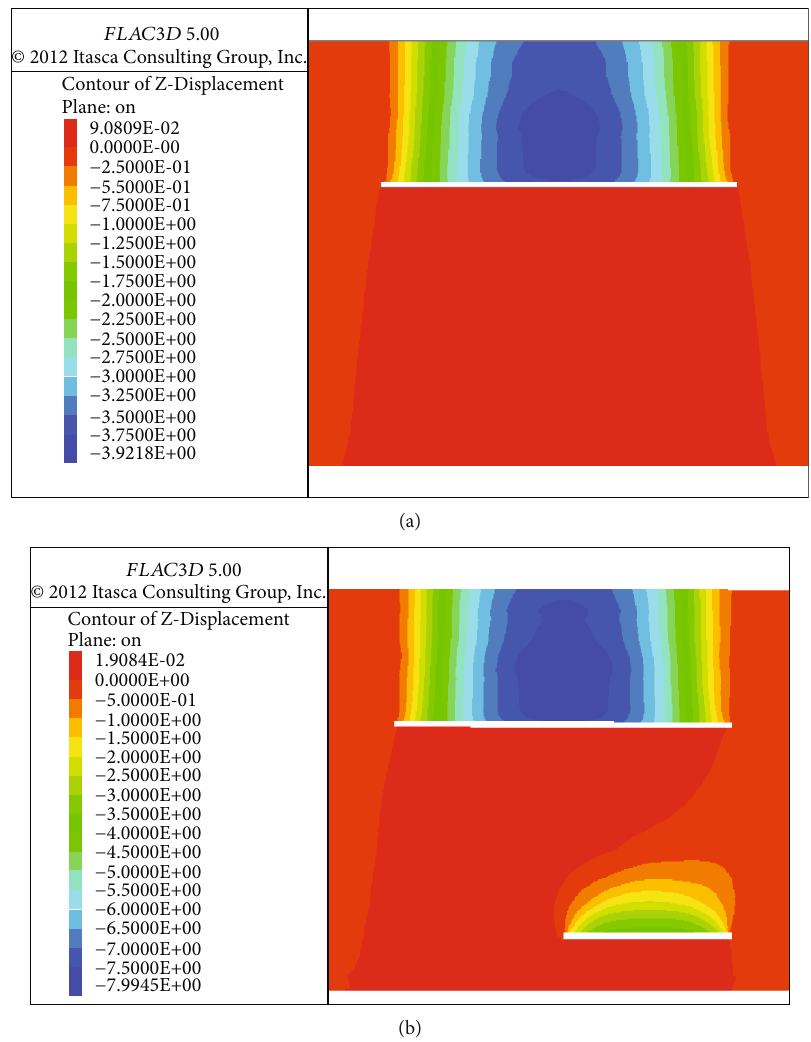
Figure 21: Displacement cloud diagrams of the mining of the (a) W coal seam in the No. 6 coal mine and (b) J coal seam in the No. 5 coal